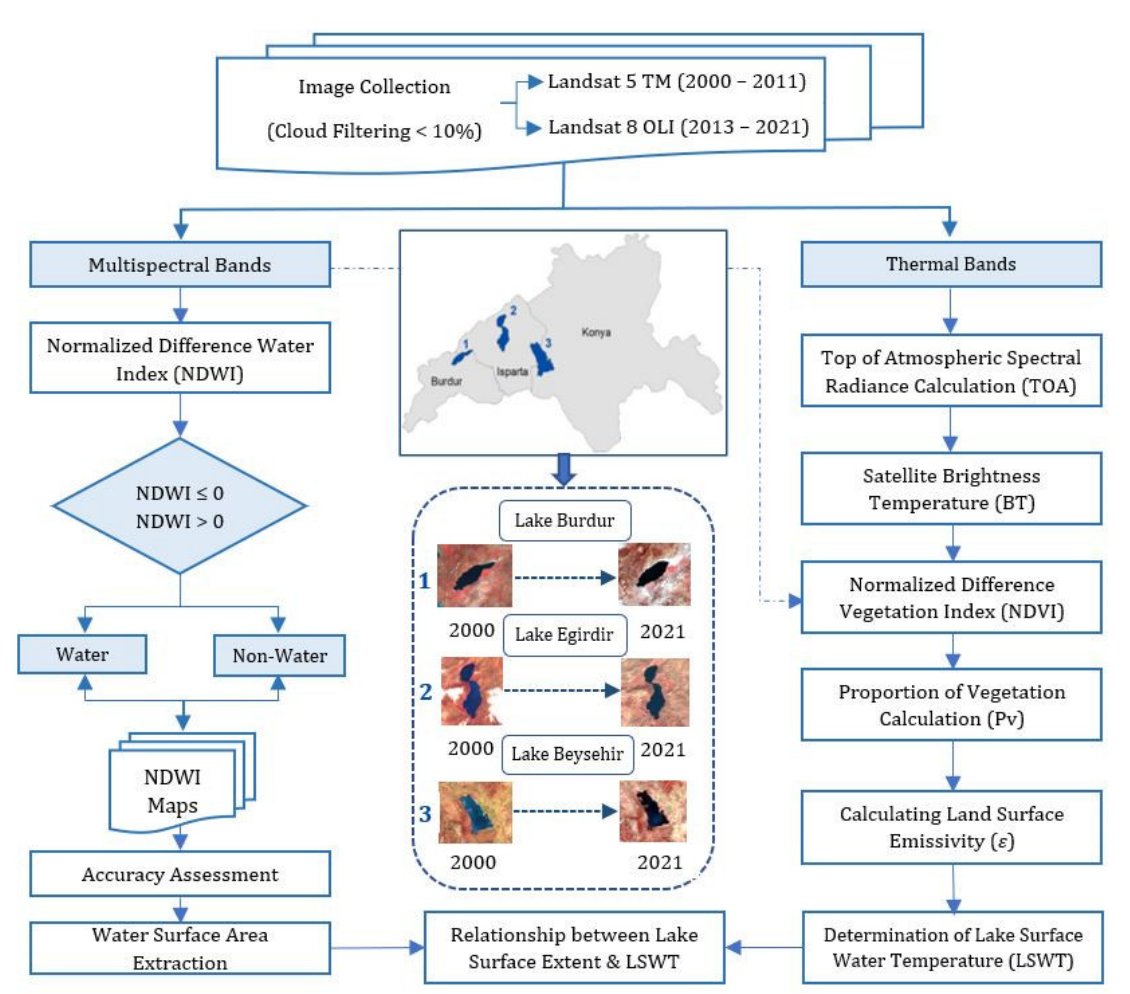
Figure 3. The workflow of the methodology used in the study.